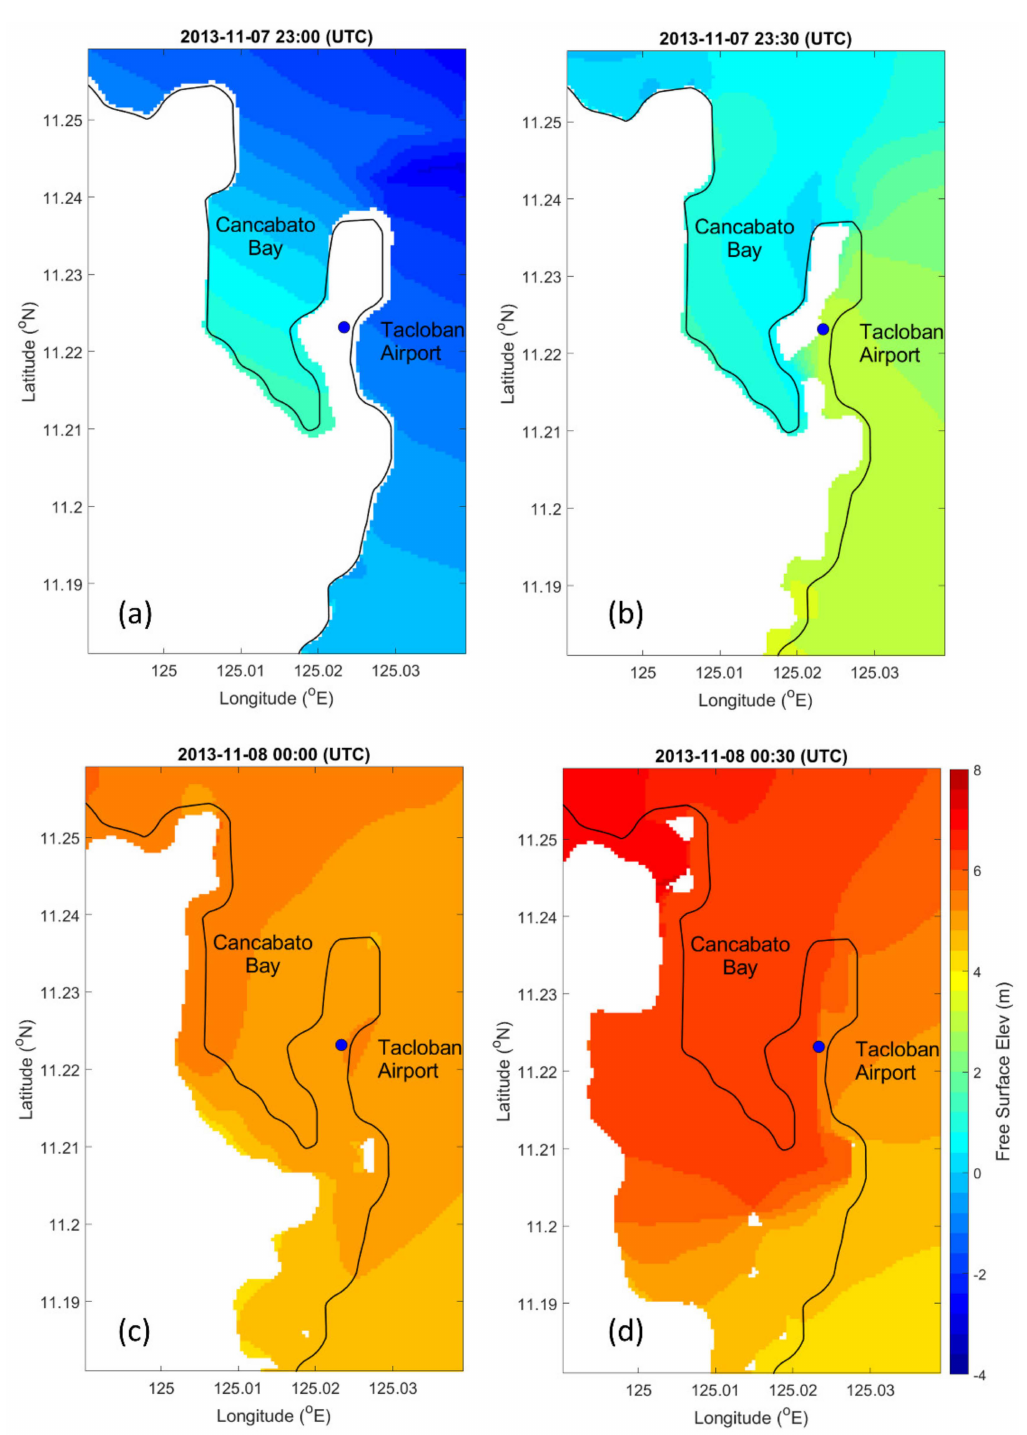
Figure 11. Computed storm surges of Domain D03: ( a ) at 23:00 UTC on 7 November 2013; ( b ) at 23:30 UTC on 7 November 2013; ( c ) at 00:00 UTC on 8 November 2013; ( d ) at 00:30 UTC on 8 November 2013. The color shading indicates the free surface elevations in m. The blue circle shows the location of the Tacloban